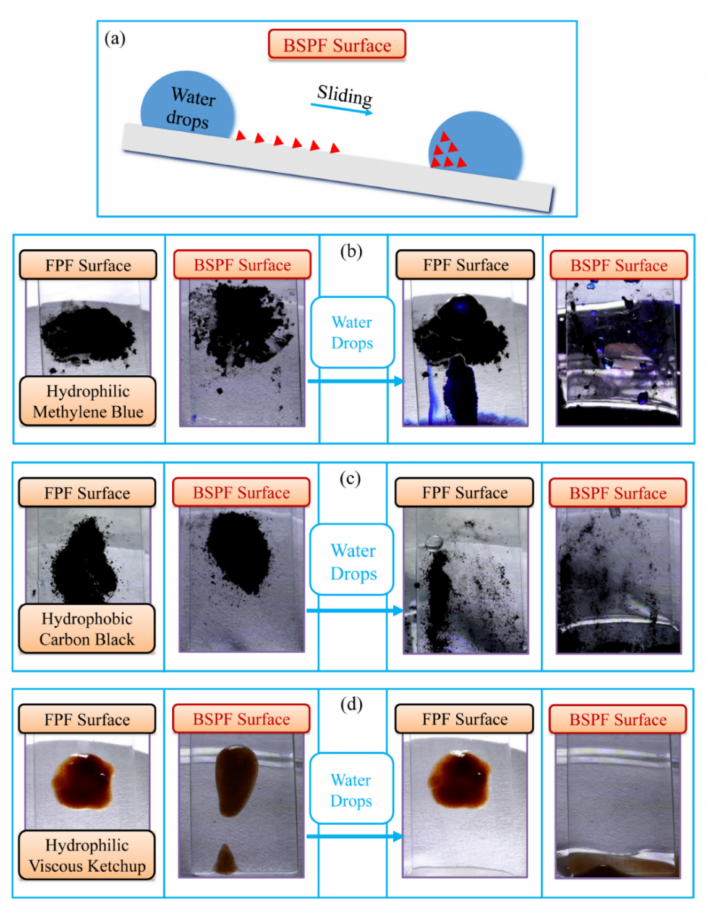
Figure 11. ( a ) Cleaning mechanism of BSPF surface defined as the “slide-to-clean” strategy; the self-cleaning ability of the three surfaces was tested by ( b ) hydrophilic dust (MB powders), ( c ) hy- drophobic dust (CB nanoparticles) and ( d ) hydrophilic liquid (viscous